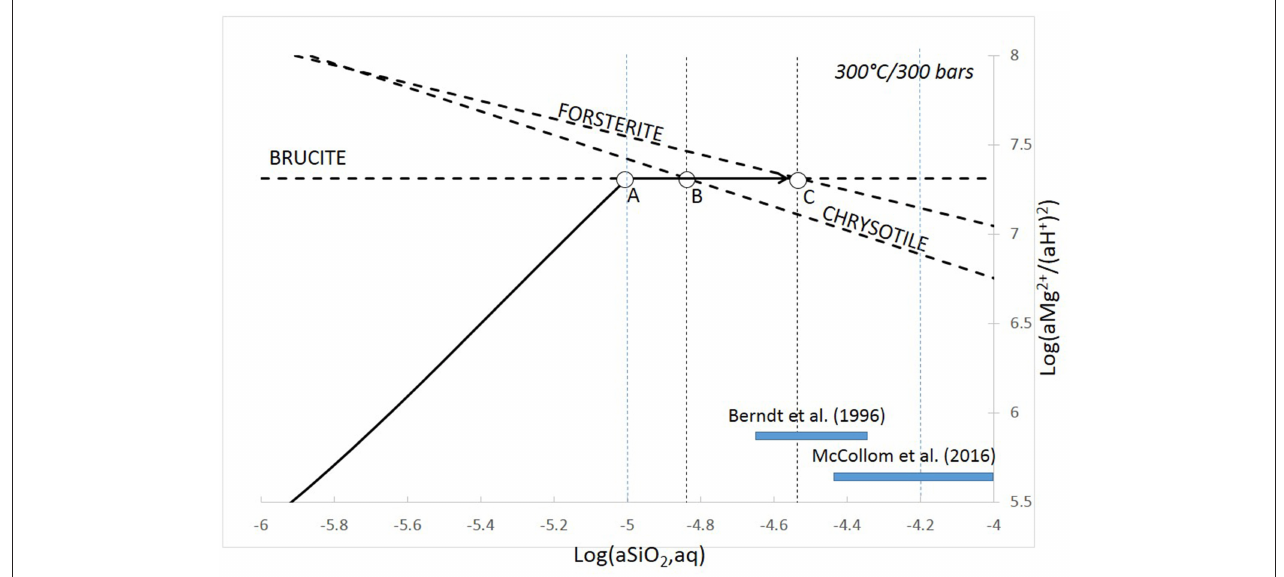
FIGURE 2 | Activity-activity diagram in the MgO-SiO 2 -H 2 O system showing the solubility limits of olivine–brucite and chrysotile. The plain line indicates a possible compositional path of the solution in response to olivine dissolution. In the constant equilibrium case, brucite would form at Point A and the solution composition should evolve until Point B, where the stable assemblage brucite + chrysotile would precipitate. Assuming that chrysotile does not form, then the composition may reach the metastable Point C, where olivine saturation is achieved. The silica concentration range (assumed here to equate to silica activity) measured in the aqueous solution of hydrothermal experiments performed at 300 ◦ C with Fe-bearing natural olivine as starting material ( Berndt et al., 1996 and McCollom et al., 2016), are reported. They are consistent with buffering by the olivine–brucite metastable equilibrium (McCollom et al.,